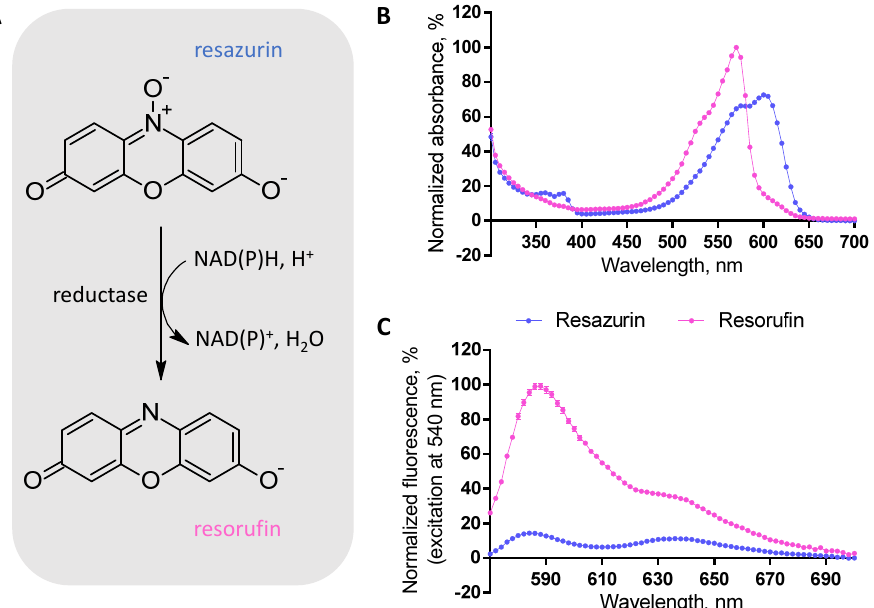
Figure 1. Structures and optical properties of resazurin and resorufin. ( A ) Schematic representation of the resazurin to resorufin conversion; enzymatic catalysis is required. ( B , C ) Absorbance and fluorescence spectra characteristics of the assay (100% corresponds to the maximal absorbance/emission intensity of resorufin and 0% to the absorbance/emission intensity of phosphate buffer within the measured wavelength range; average of triplicates ± SEM from a single representative experiment is shown). The resorufin spectra were registered after 2.5 h incubation of 50 μ M resazurin with U-251 MG cells (96 h post-seeding, initial seeding density of 6250 cells/well) on the 96-well plate, while the resazurin spectra were registered after 3 h incubation of 50 μ M resazurin on the 96-well plate in the absence of cells.